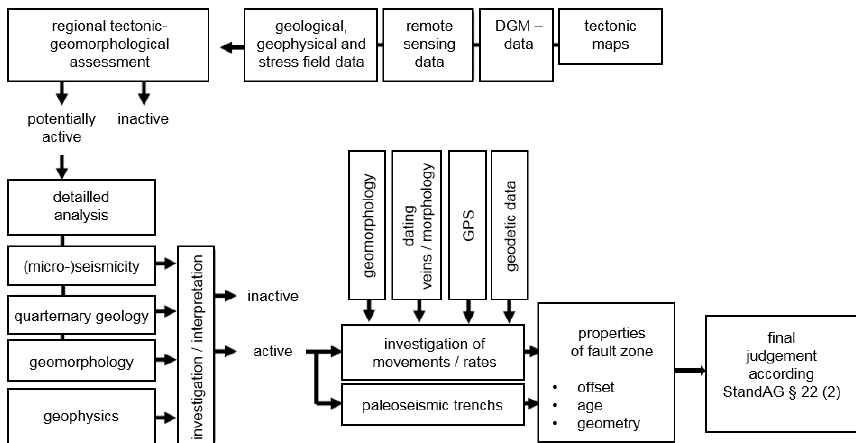
Figure 2. Suggested principal work-flow for the identification and characterization of active faults and fault zones and application of the exclusion criterion of § 22 (2) 2 Site Selection Act according to Brosig et al. (2020). Modified after Decker et al. (2017).